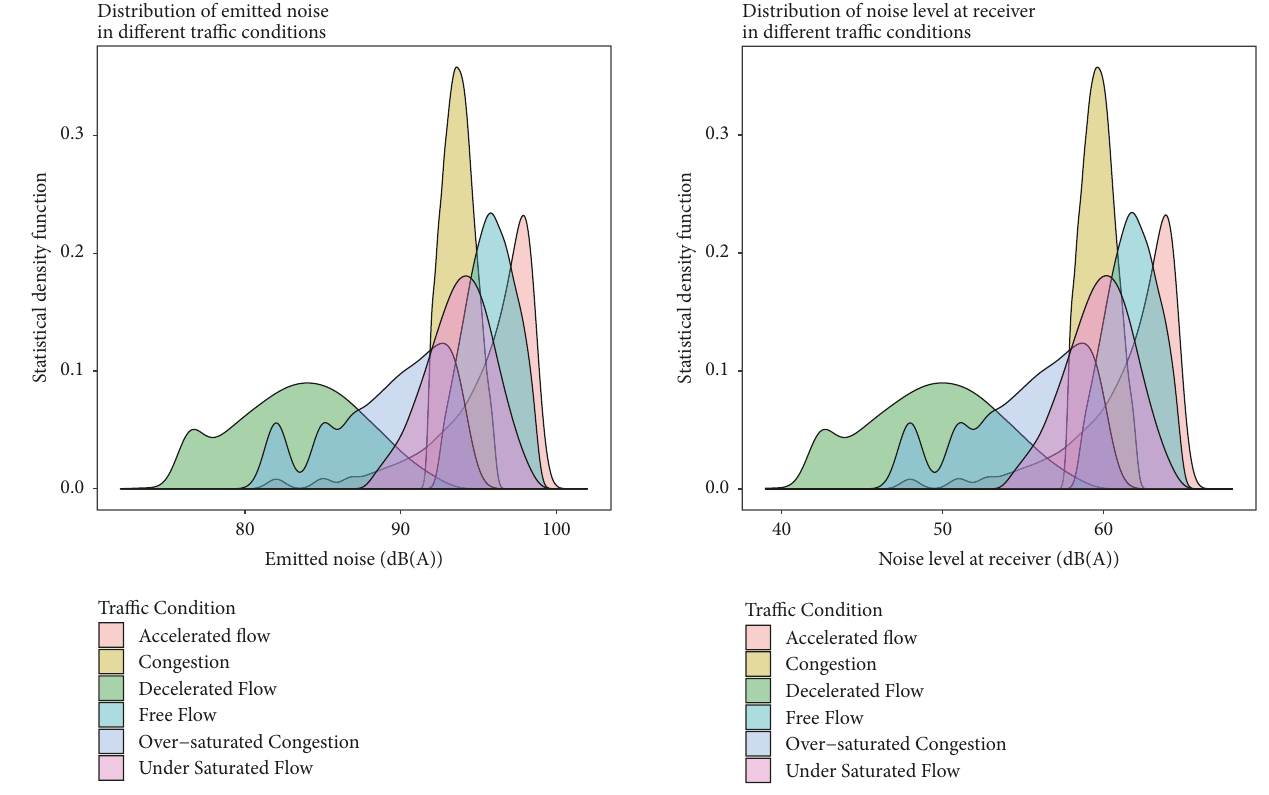
Figure 6: Comparing the distributions of emitted noise in different traffic conditions.